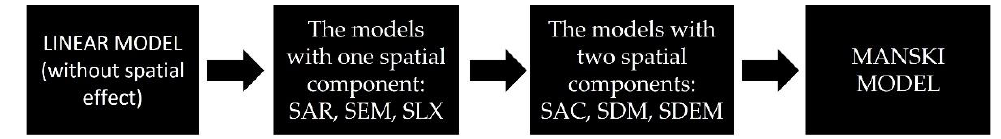
Figure 4. The relationships between different spatial dependence models for cross-section data.